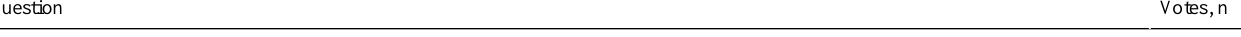
Table 2. The most important small group discussion summary statements ( ≥ 6 votes), as voted by focus group participants. The focus group participants were able to vote for the same statement multiple